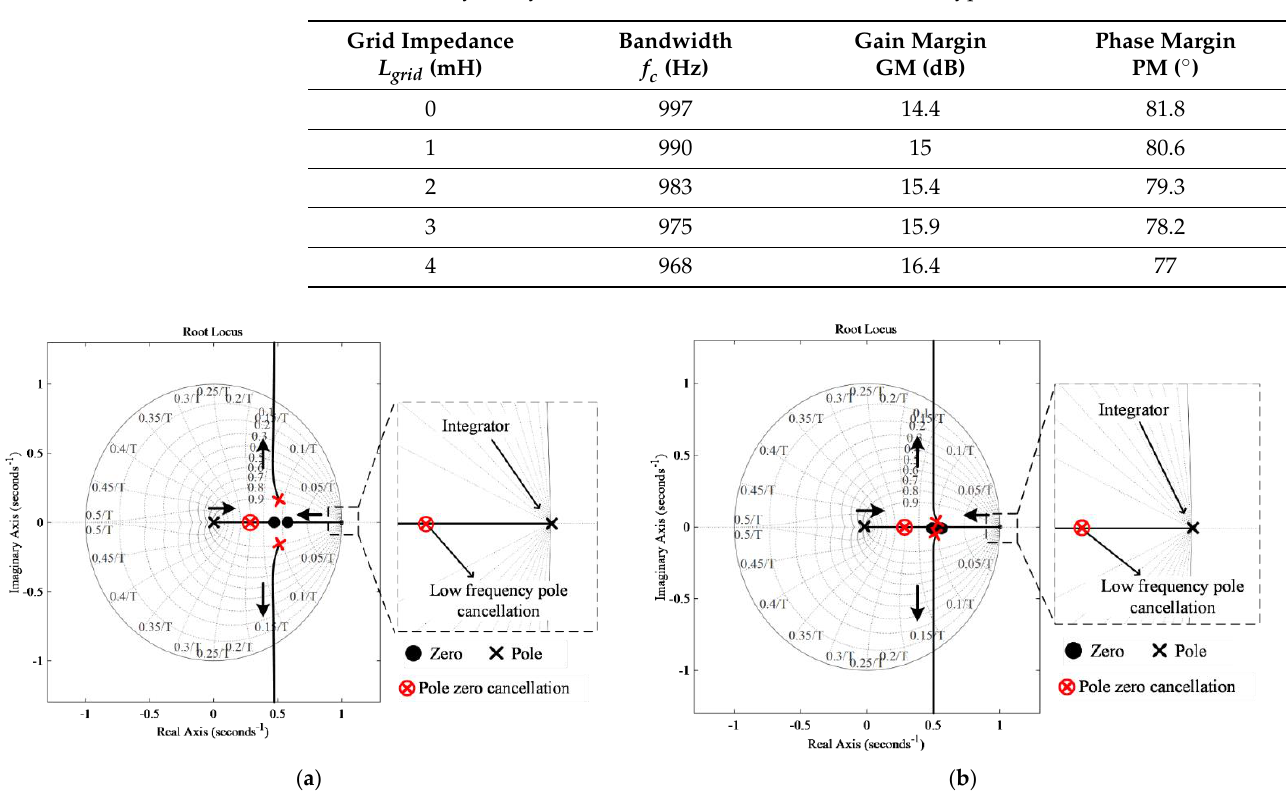
Figure 10. Pole-zero map of loop gain transfer function for L filter type GcI with FESO-based ADRC ( a ) For L grid = 0; ( b ) L grid = 4mH.